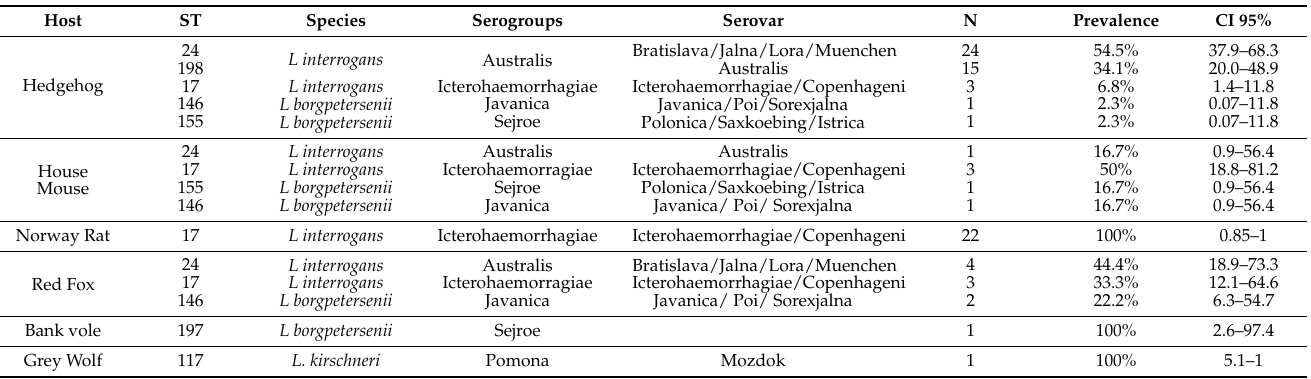
Table 3. Synanthropic and wild animals positive for Leptospira spp. and the MLST analysis, reported for each Leptospira serogroups. Prevalence and confidence interval (CI) are reported for the Sequence Type found in each